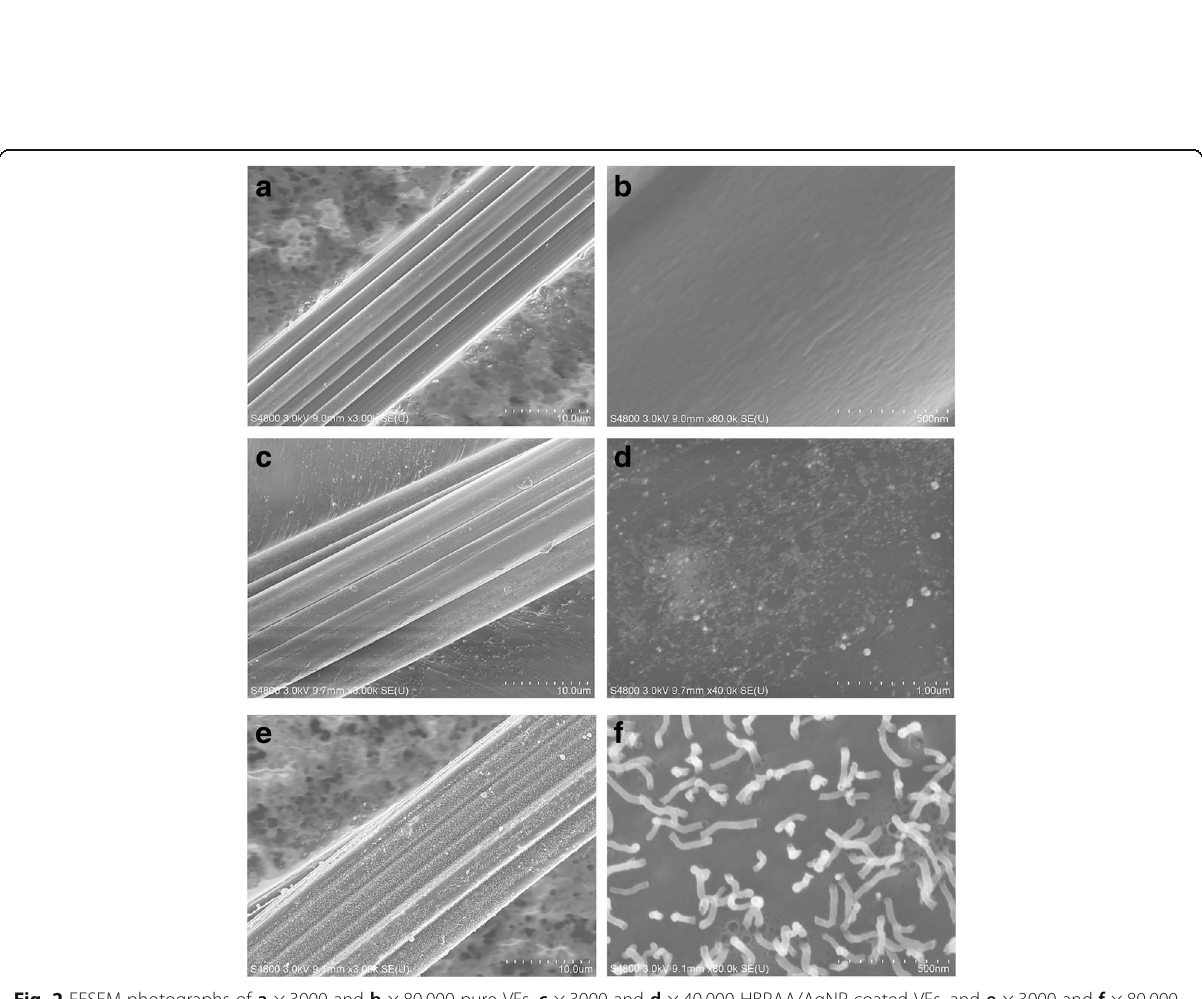
Fig. 2 FESEM photographs of a × 3000 and b × 80,000 pure VFs, c × 3000 and d × 40,000 HBPAA/AgNP-coated VFs, and e × 3000 and f × 80,000 Ag nanohair-grown